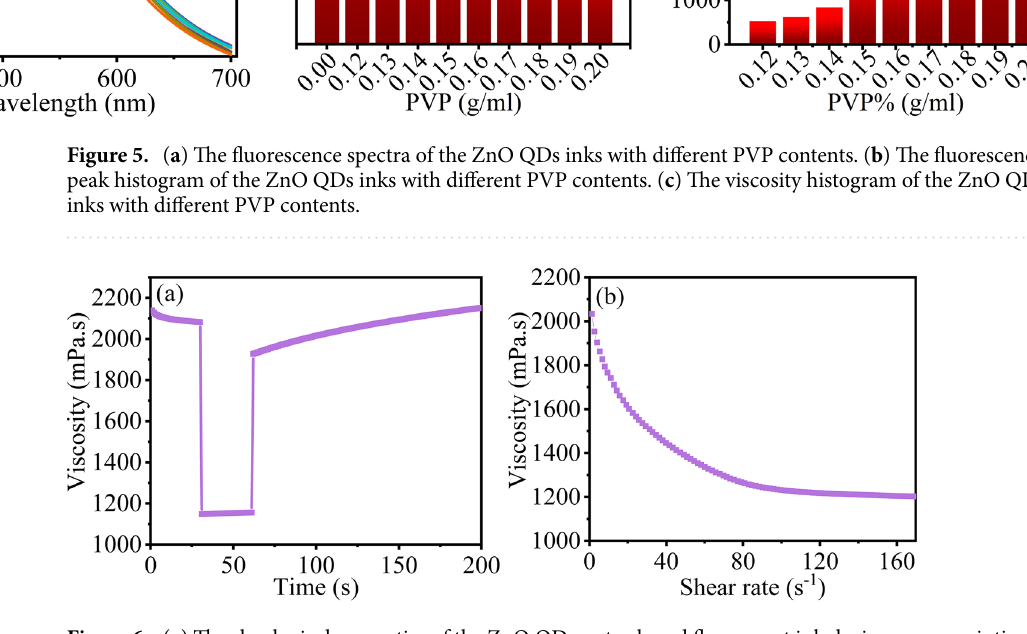
Figure 6. ( a ) The rheological properties of the ZnO QDs water-based fluorescent ink during screen printing (25 °C). ( b ) The shear properties of the ZnO QDs water-based fluorescent